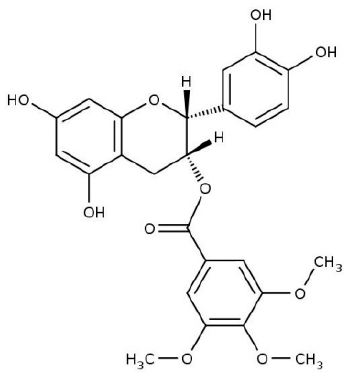
Figure 1. Structure of 3- O -(3,4,5-trimethoxybenzoyl)-( − )-catechin (TMCG).